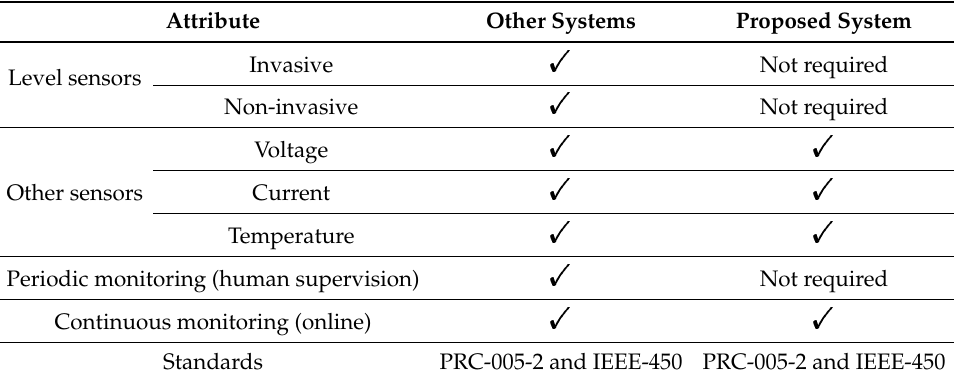
Table 1. Comparison between the proposed method and those commonly used in supervisory systems (for continuous supervision) that monitor the electrolyte level.